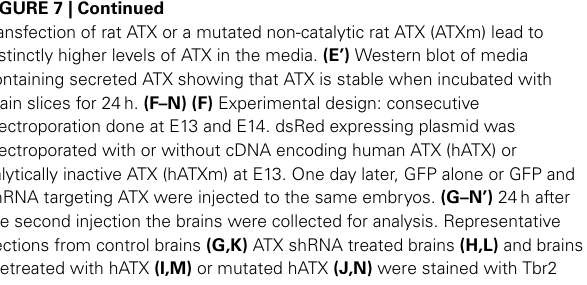
(K–N) and DAPI. (K’–N’) Signal recorded along the width of the cortex showing the dispersion of cells along the radial aspect of the cortex